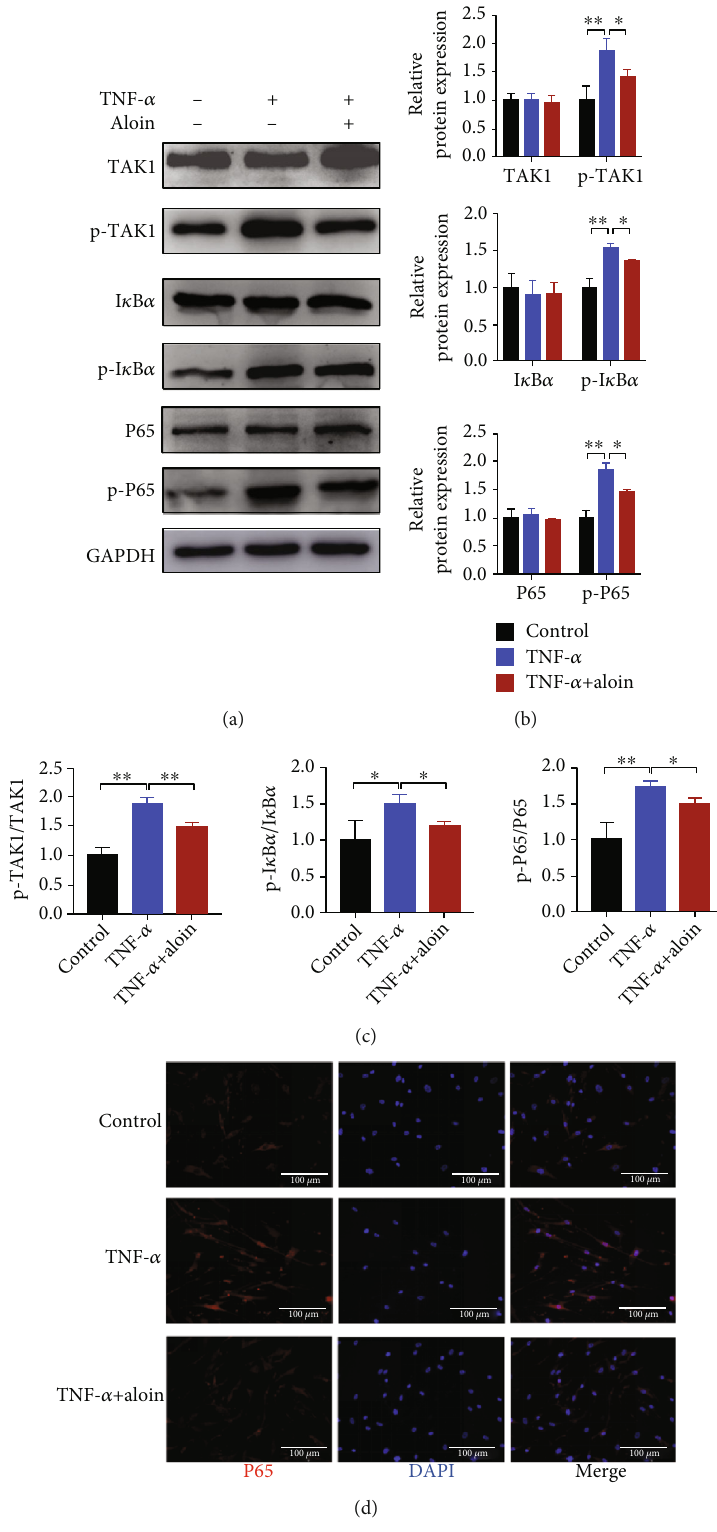
Figure 5: Aloin suppresses the activation of the TAK1/NF- κ B pathway. (a) Protein expression levels of the TAK1/NF- κ B signaling pathway (TAK1, p-TAK1, I κ B α , p-I κ B α , P65, p-P65) were detected by western blotting in di ff erent groups. (b) The protein bands were quanti fi ed using the ImageJ software. (c) The expression ratios of p-TAK1/TAK1, p-I κ B α /I κ B α , and p-P65/P65 in the di ff erent groups. (d) Localization of P65 was assessed via immuno fl uorescence. Images (magni fi cation: × 200, scale bar: 100 μ m). In this fi gure, aloin was used at the concentration of 200 μ M, while TNF- α was at the concentration of 10ng/ml. ∗ P < 0 : 05 , ∗∗ P < 0 : 01